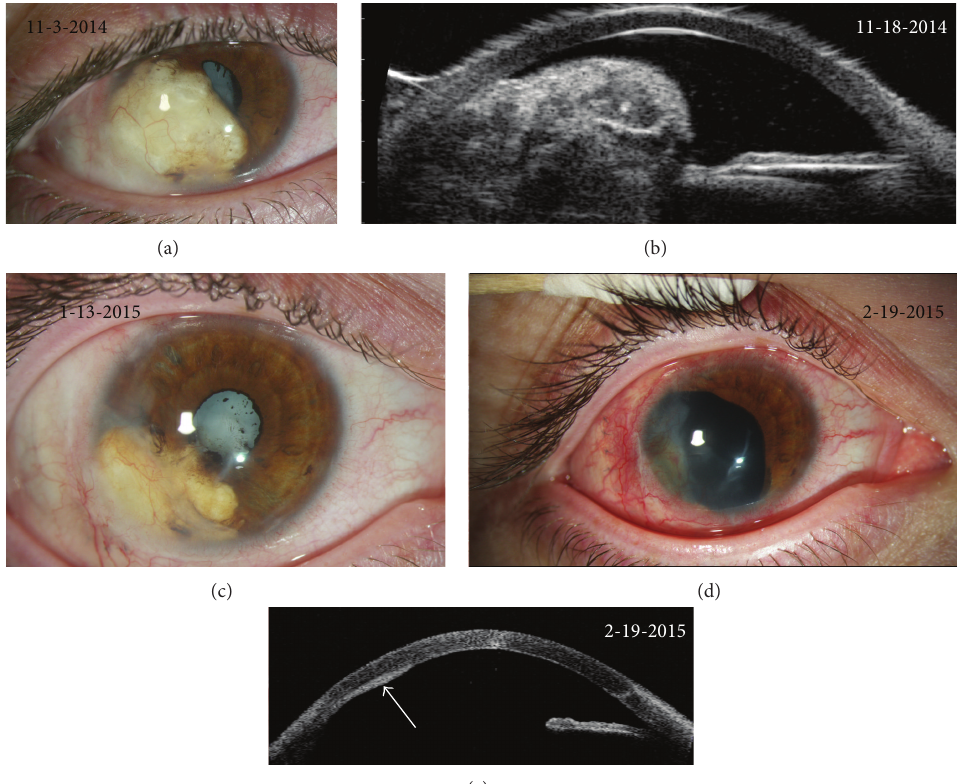
Figure 2: Clinical and diagnostic images from case 1: subsequent presentation. (a) Slit-lamp photograph illustrating recurrence of the iris cyst along the inferotemporal iris after the patient was lost to follow-up for 1.5 years. Posterior synechiae have developed and the pupil is largely obstructed by the iris cyst. A white cataract can be seen through the small pupillary opening. (b) Ultrasound biomicroscopic images demonstrating copious echogenic material within the iris cyst. Normal iris and angle structure are disrupted and the cyst abuts the ciliary body. (c) Slit-lamp photograph showing shrinkage of the iris cyst after repeat debulking of the cyst and intracystic injection of 5-FU. (d) Slit-lamp photograph four weeks after surgical excision of the cyst demonstrating a large sector iridectomy. The cataract was removed with a vitrector and the patient is aphakic. The temporal cornea demonstrates posterior opacity and vascularization in the area previously abutted by the cyst. (e) AS-OCT image four weeks after surgical excision of the cyst. The sector iridectomy is seen. There is increased reflectivity and thickening on the posterior cornea in the area previously adjacent to the cyst where neovascularization and scarring were identified by slit-lamp biomicroscopy